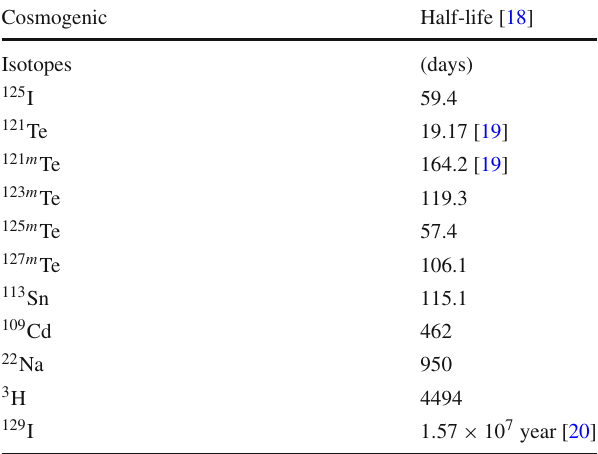
Fig. 2 Detector response to the calibration data points is described by Eq. 1 (red line) for five NaI(Tl) crystals at low energy. Data points are 22 Na, 40 K, 109 Cd, 121 Te, 210 Pb, and 125 I from left to right Table 1 Cosmogenic radionuclides in the NaI(Tl) crystals identified in other studies and considered here [17]. We list the contributing cosmo- genic isotopes with their half